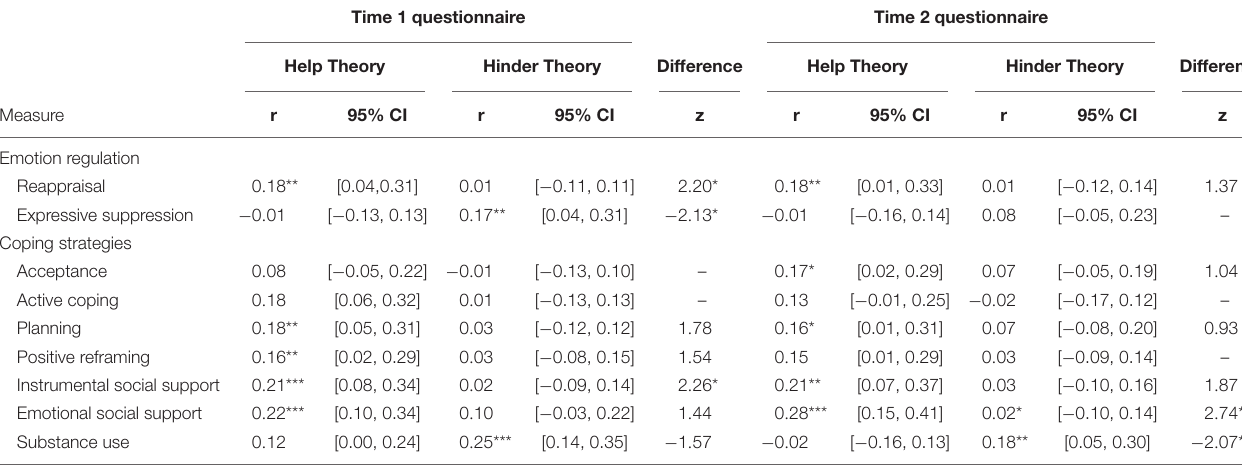
TABLE 3 | Study 1 correlations of HHTEM subscales with emotion regulation and coping strategies at Time 1 and Time 2, and tests of the difference between dependent